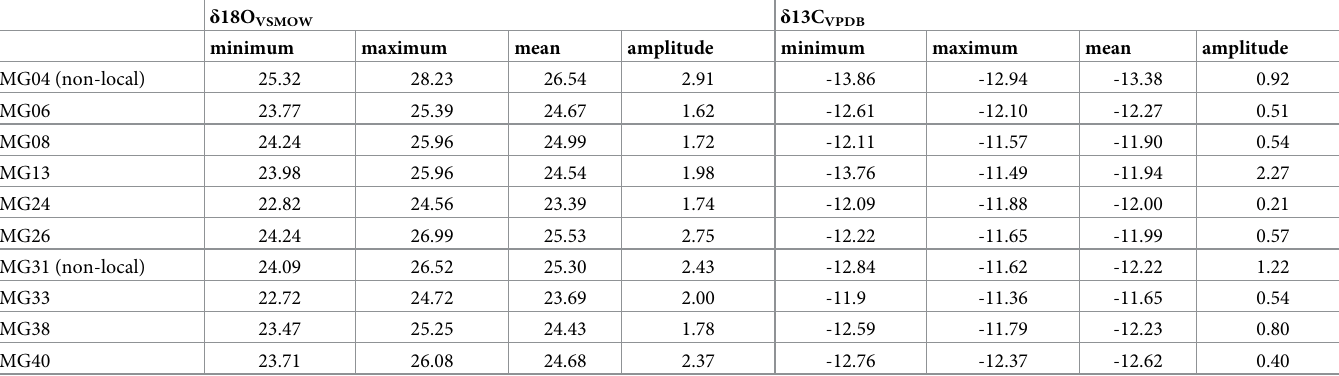
Amplitude: intra-tooth peak-to-peak amplitude of